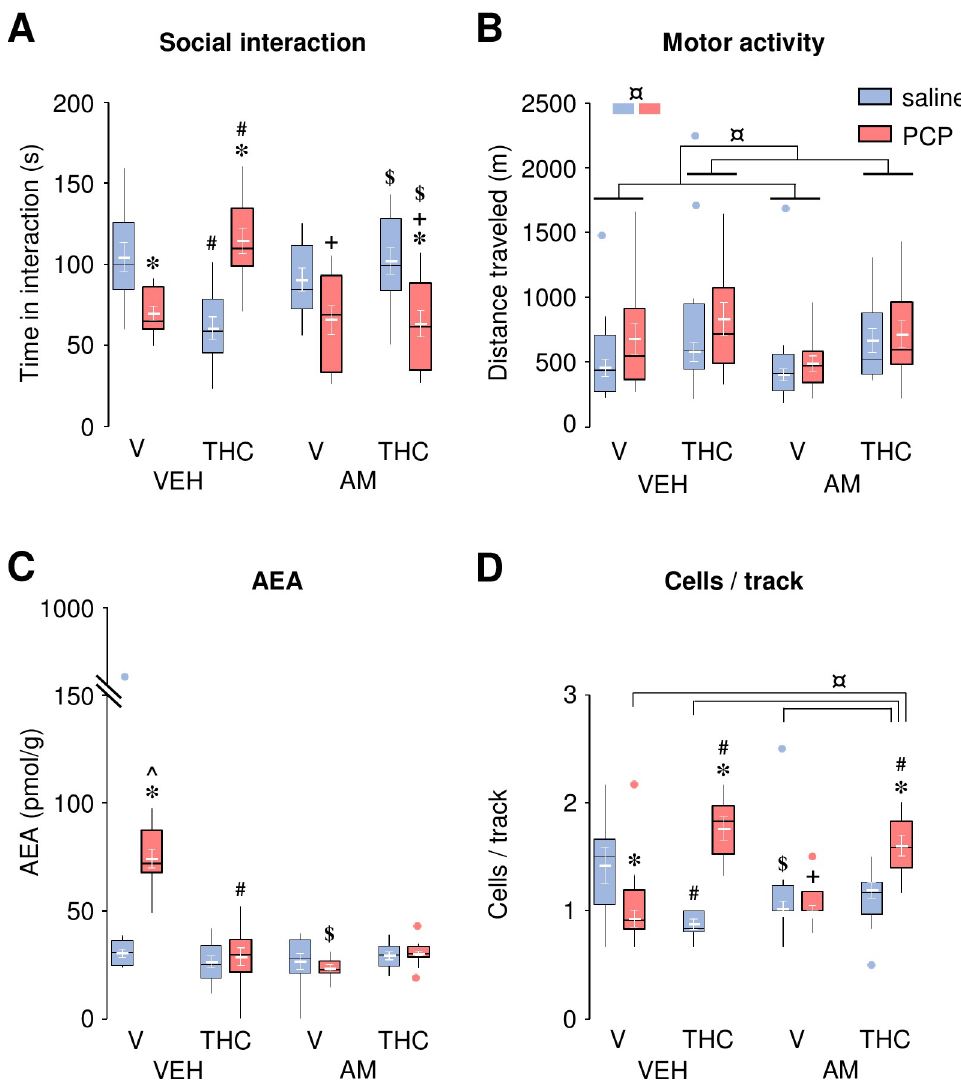
Fig 5. Role of CB 1 receptors in THC mediated effects. The CB 1 antagonist AM251 (AM; 1 mg/kg, i.p.) reversed the effects of THC (0.01 mg/kg, i.p.) on social interaction in saline- and PCP-treated animals ( A ). AM251, but not THC, might prevent the trend for increased motor activity after d -amphetamine (0.5 mg/kg, i.p.) administration in PCP- treated rats compared to saline-control animals ( B ). Both AM251 and THC blocked PCP-induced increase in AEA levels in the nucleus accumbens ( C ). AM251 failed to reverse THC beneficial effect (in PCP-treated animals) on the number of spontaneously active cells per track in the VTA ( D ). The raw data for this figure are reported in the supplemental file (S1 Raw data) and are summarized here as boxplots computed using Carling’s modification [42];outliers are depicted as blue (saline) or red (PCP) circles. Values (in white) are expressed as mean ± S.E.M. (n = 10–12, 8–12 and 5–8 per group, for the behavioral, neurochemical and electrophysiological data, respectively). � P < 0.05 compared to saline-treated controls, # P � 0.05 compared to vehicle (V) controls, + P < 0.05 compared to saline-treated vehicle (V) controls, $ P < 0.05 compared to vehicle (VEH) controls, ^ P < 0.05 compared to all other groups (Newman-Keuls post-hoc